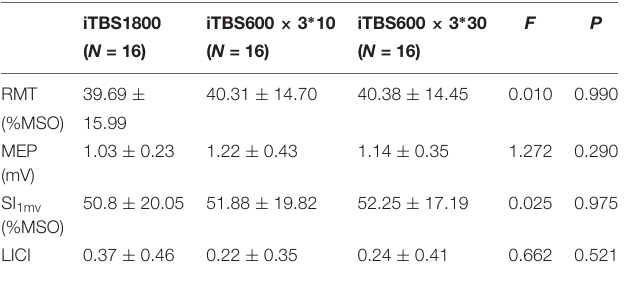
TABLE 2 | Subjects’ baseline RMT, MEP amplitude, SI 1mv , and LICI when started three different iTBS conditions. iTBS1800